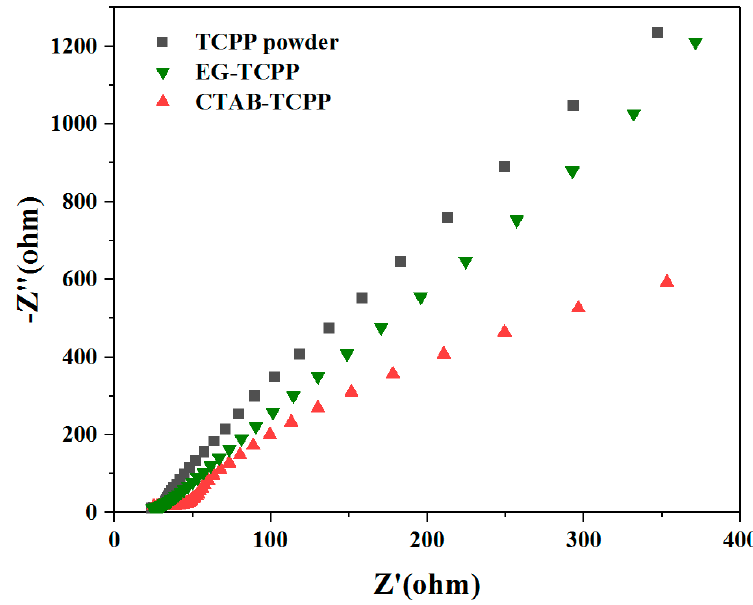
Figure 12. Electrochemical impedance spectra (EIS) of different TCPP aggregates.